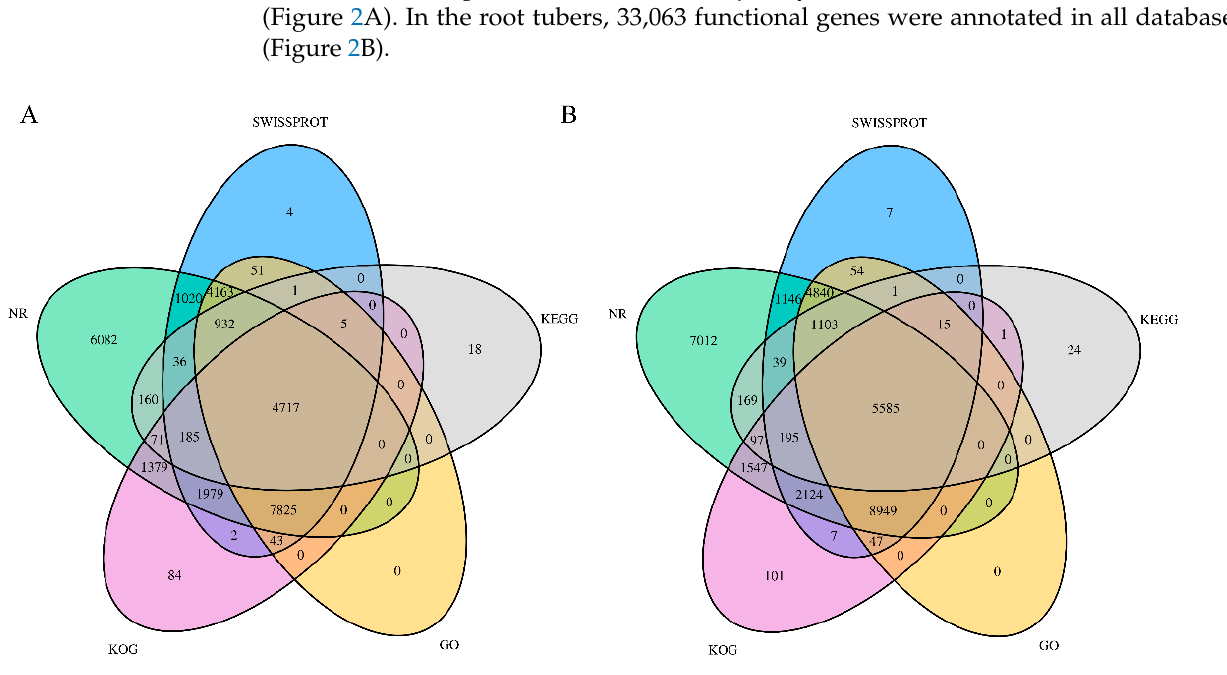
Figure 2. Venn diagrams of unigene annotations. ( A ) Venn diagram of KOG, NR, SwissProt, KEGG, and GO gene database annotation from leaves of T. hemsleyanum ; ( B ) Venn diagram of NT, NR, SwissProt, KEGG, and GO gene database annotation from root tubers.